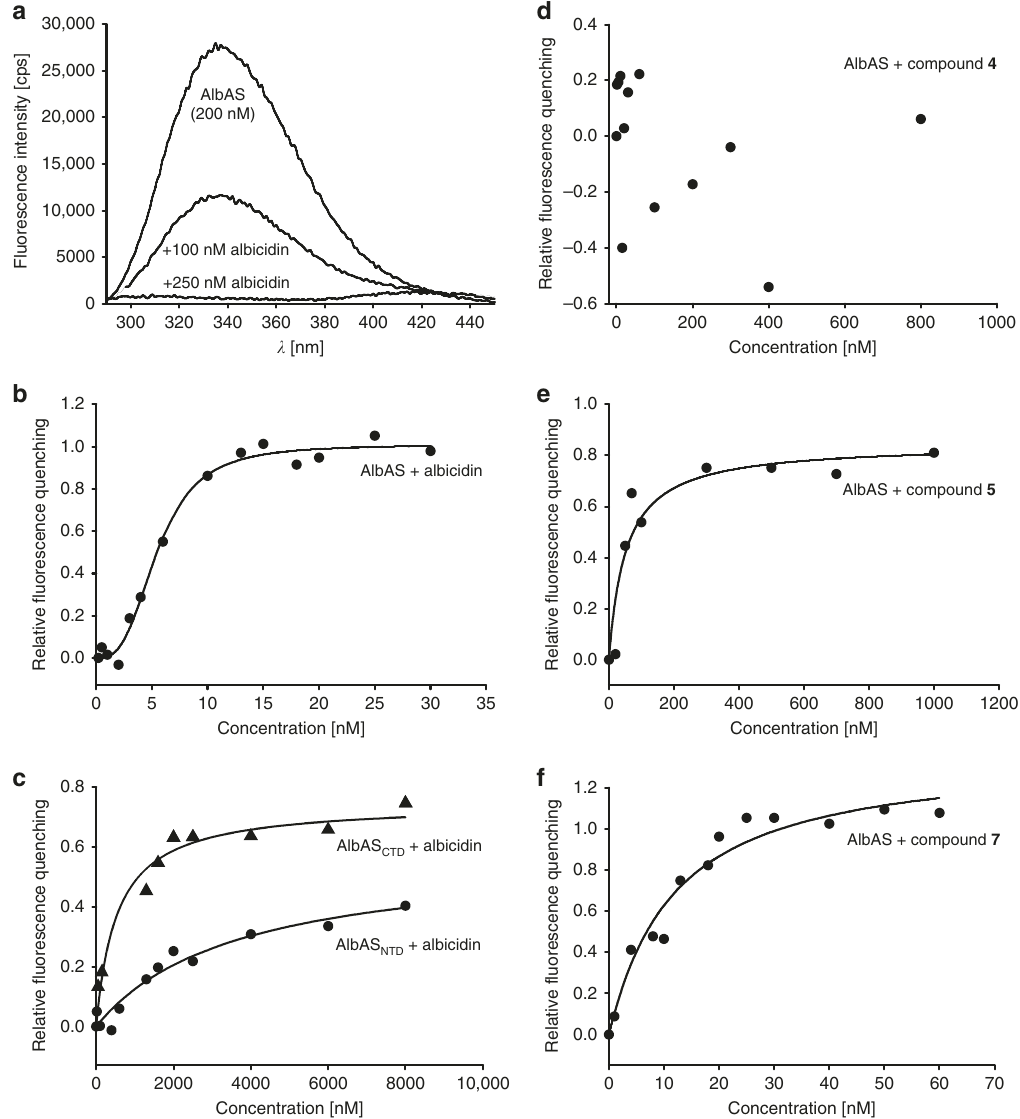
Fig. 4 Determination of binding af fi nities by monitoring quenching of fl uorescence emission of AlbAS. a Fluorescence quenching of AlbAS (200 nM; λ exc = 280 nm) with increasing albicidin concentrations. b Nonlinear regression (Eq. (2), see Methods section) of fl uorescence quenching data yielding a K d of 5.6 ± 0.2 nM and a Hill coef fi cient, n , of 3.0 ± 0.5 for the interaction of albicidin with AlbAS (20 nM). c Nonlinear regression of the quenching data yielded K µ M for the interaction of albicidin with the dissected domains AlbAS d values of 3.4 ± 0.2 and 0.6 ± 0.1 NTD (100 nM) and AlbAS CTD (100 nM), respectively. d AlbAS (20 nM) titrated with compound 4 did not lead to signi fi cant quenching of the fl uorescence emission signal. e Titration of AlbAS (20 nM) with compound 5 yielded a K d of 55.5 ± 3.6 nM (Eq. (2), see Methods section). f Titration of AlbAS (20 nM) with compound 7 yielded a K d of 14.0 ± 2.9 nM (Eq. (3), see Methods section). Representative binding curves are shown for two independent experiments each. Errors are given as s.d